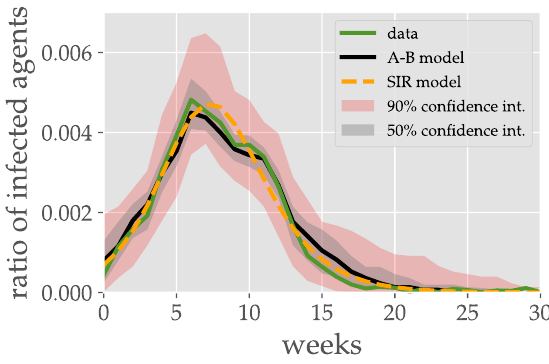
Figure 8. Comparison of SIR and AB model with observed